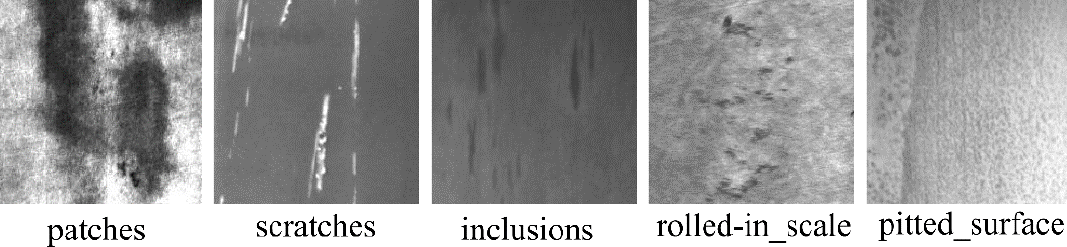
Figure 6. Pictures of different defect types.